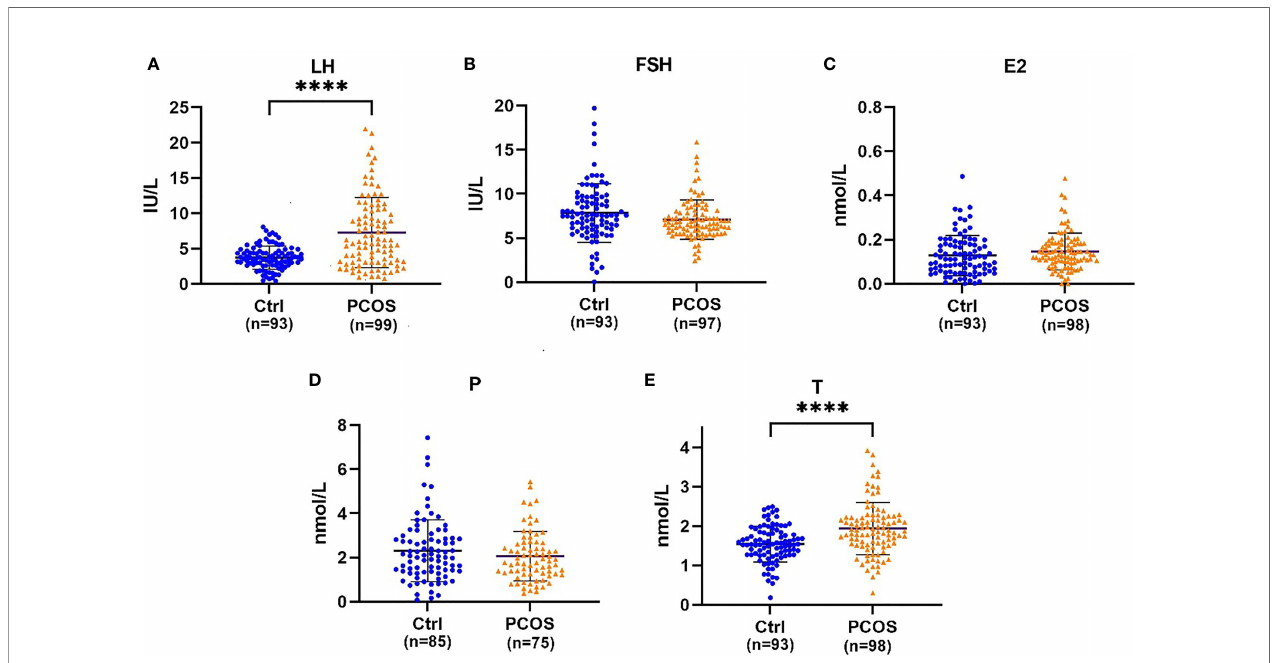
FIGURE 1 | (A) Beeswarm plots illustrating the distribution of LH (luteinizing hormone), (B) FSH (follicle-stimulating hormone), (C) E2 (estradiol), (D) P (progesterone), and (E) T (testosterone) serum concentrations. Error bars represent the standard deviation, and the black line between two dark lines represents the mean. ****Statistical signi fi cance (P <